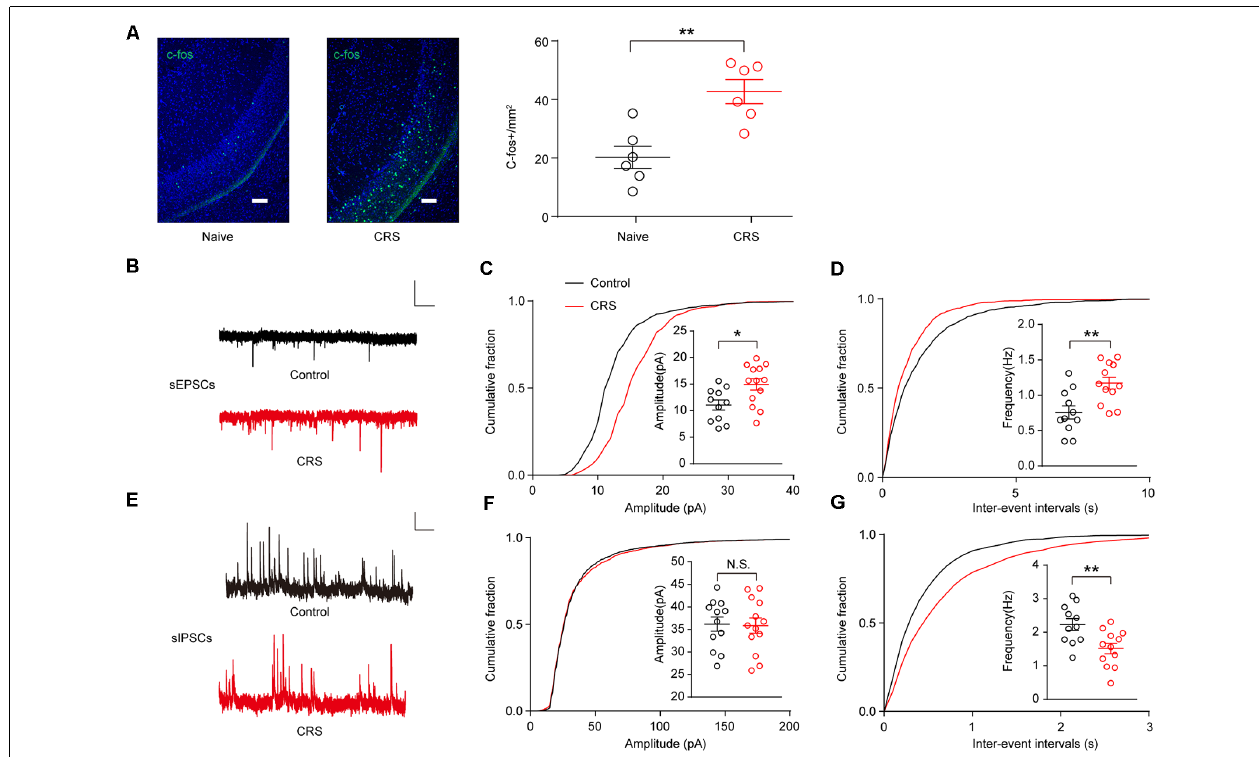
FIGURE 3 | CRS increases ventral hippocampal activity by enhancing excitatory postsynaptic currents (EPSCs) and decreasing inhibitory postsynaptic currents (IPSCs). (A) Representative images of c-Fos (green) staining in the vHPC. Scale bar, 100 µ M (Left). Quantification of vHPC c-Fos+ cells after CRS (Right). Unpaired two-tailed Student’s t -test, t (10) = 4.013, p = 0.0025. (B) Representative spontaneous EPSC (sEPSC) traces of neurons in vHPC. Scale bar: 10 pA, 1 s. (C) Cumulative distribution of sEPSC amplitudes and average amplitudes. Unpaired two-tailed Student’s t -test, t (22) = 2.685, p = 0.0135. (D) Cumulative distribution of sEPSC inter-event intervals and average frequencies. Unpaired two-tailed Student’s t -test, t (21) = 3.337, p = 0.0031. (E) Representative spontaneous IPSC (sIPSC) traces of neurons in vHPC. Scale bar: 10 pA, 1 s. (F) Cumulative distribution of sIPSC amplitudes and average amplitudes. Unpaired two-tailed Student’s t -test, t (23) = 0.1448, p = 0.8862. (G) Cumulative distribution of sIPSC inter-event intervals and average frequencies. Unpaired two-tailed Student’s t -test, t (21) = 3.027, p = 0.0064. The data are presented as the mean ± SEM, N.S.: not significant, * p < 0.05, ** p < 0.01. The numbers of recording neurons are shown in